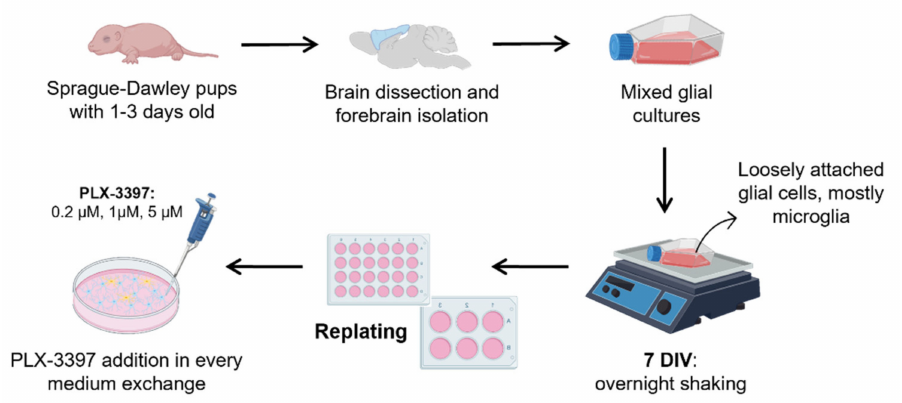
Figure 1. Step-by-step preparation of highly enriched cultures of astrocytes. Cells were maintained in T75 flasks from seeding until 7 DIV, when overnight shaking and replating took place. PLX-3397 was added from 7 DIV onwards in every medium exchange. DIV, days in vitro. Created with